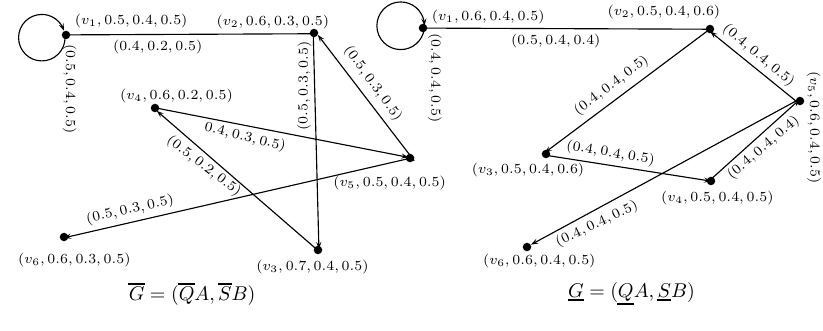
Figure 1: Neutrosophic soft rough graph G = ( G, G ) Figure 1. Neutrosophic soft rough graph G “ p G , G